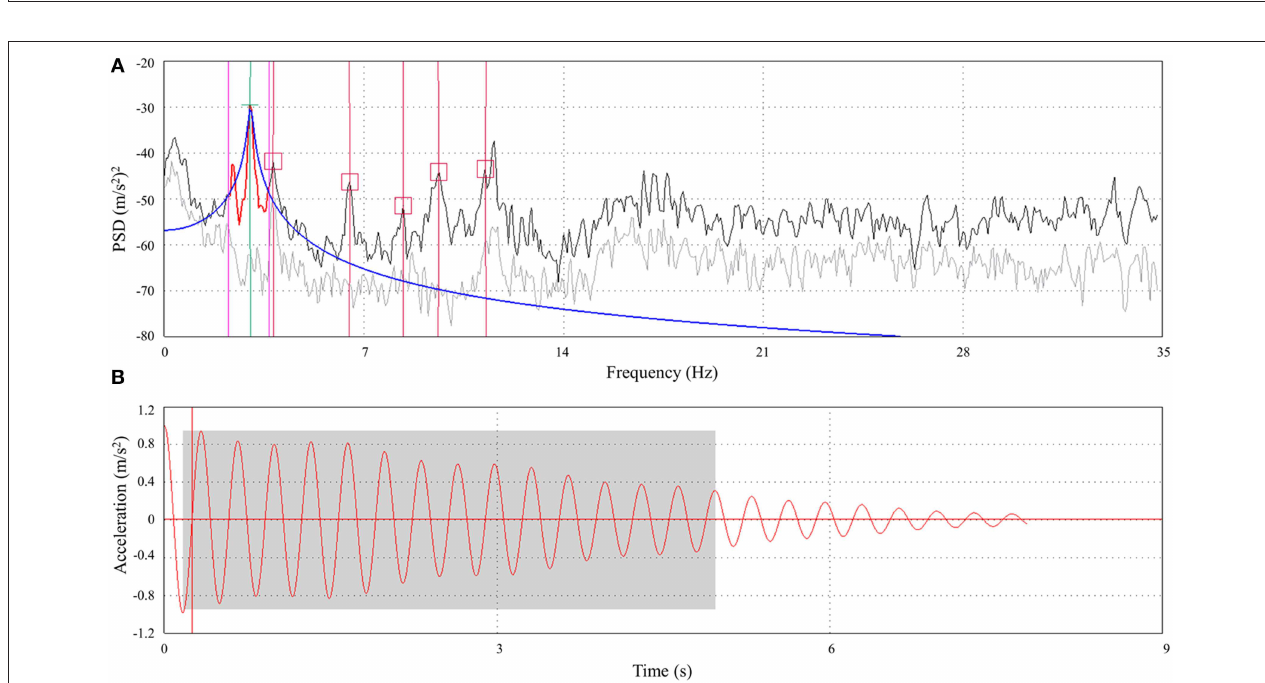
FIGURE 10 | Determination of dynamic parameters: (A) singular values of PSD matrices–1st natural frequency; (B) damping function–1st mode shape (Franˇci´c et al., 2012).